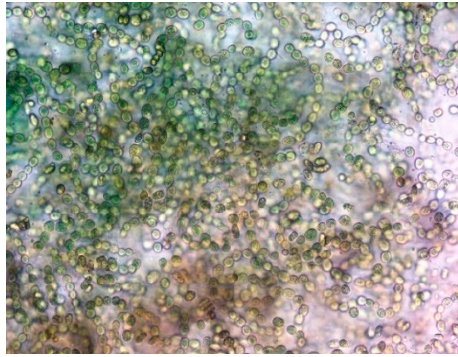
Figure 6. Biofilm on the surface of the Vysoké Mýto bricks. A photo was taken under the light microscope Olympus BX43 with a CMOS camera (magnification 400×).